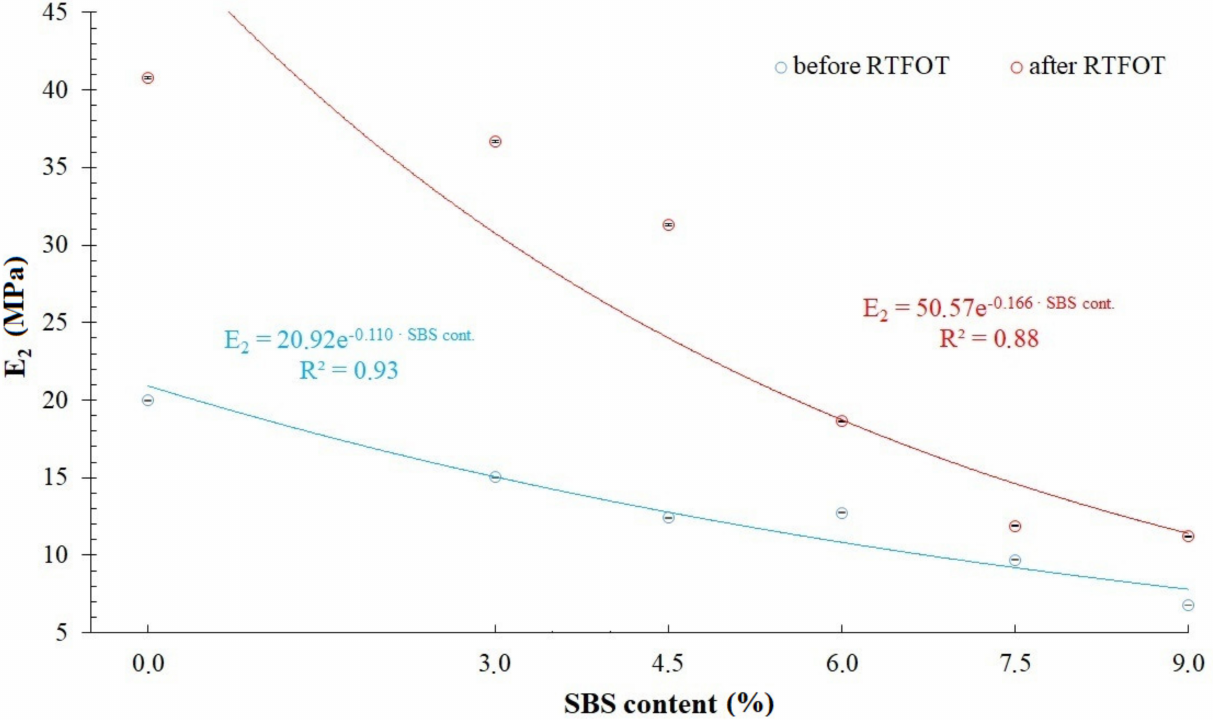
Figure 12. Values of modulus of elasticity (parameter E 2 ) in a modified generalized Maxwell model with four